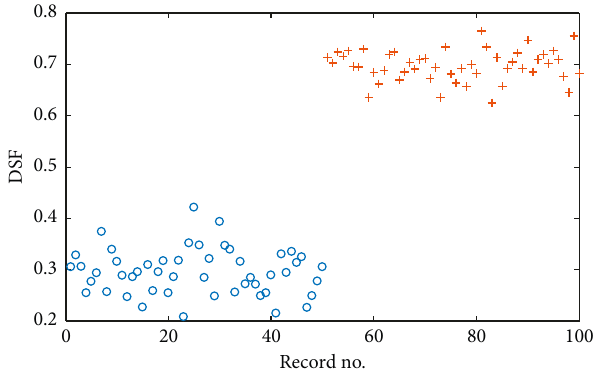
Figure 6: DSF obtained from example data (reproduced from [24], under the Creative Commons Attribution-NonCommercial 4.0 International License).